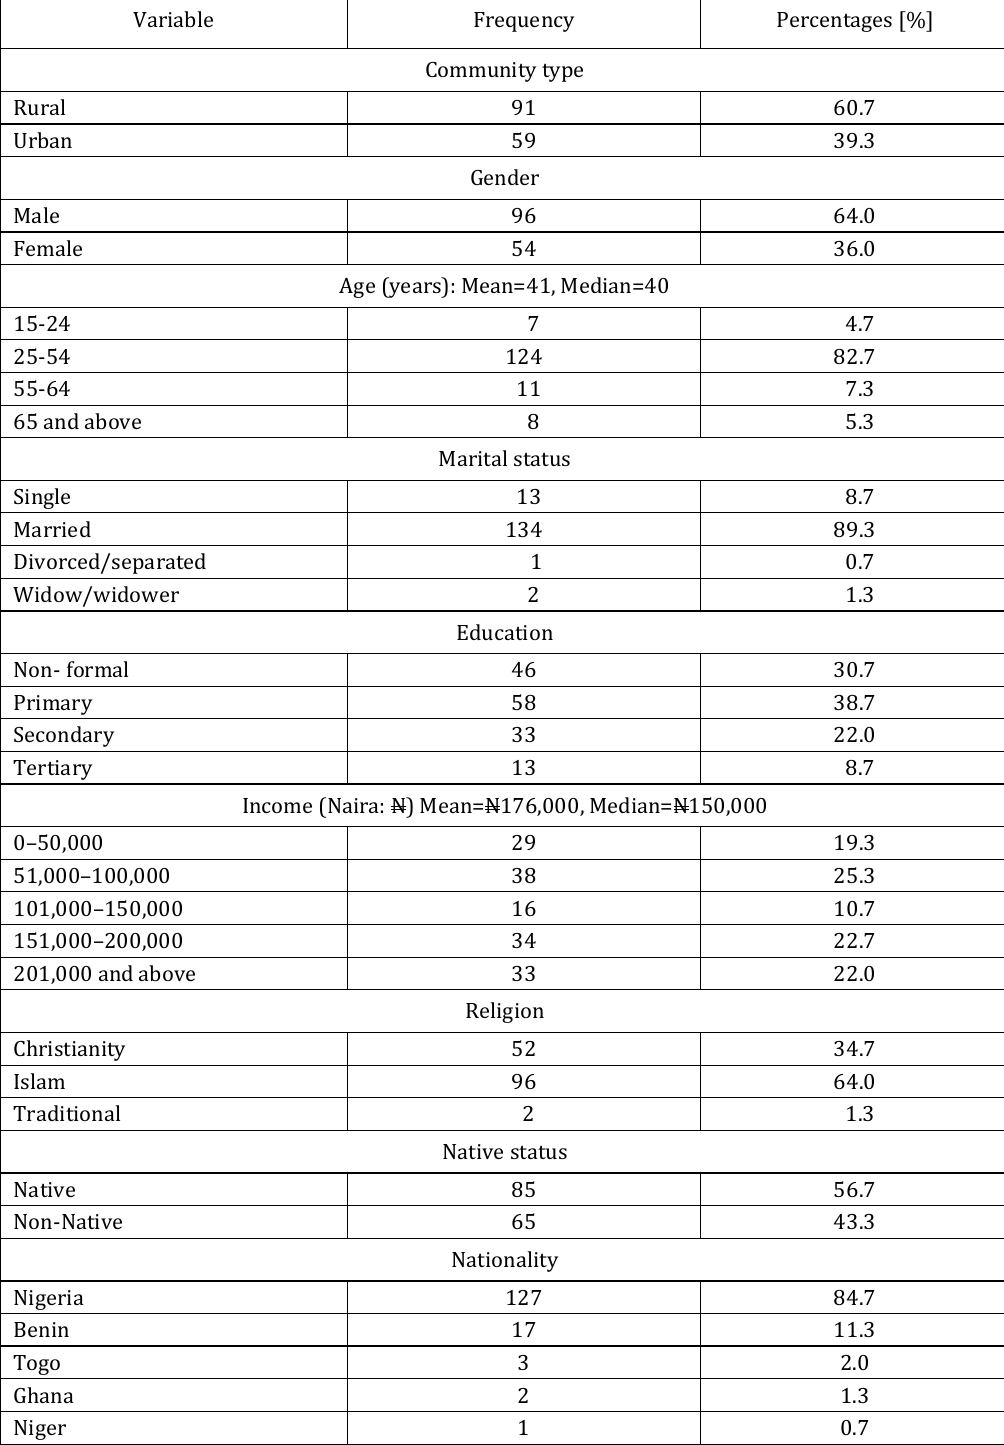
Table 2. Socio-demographic features of respondents